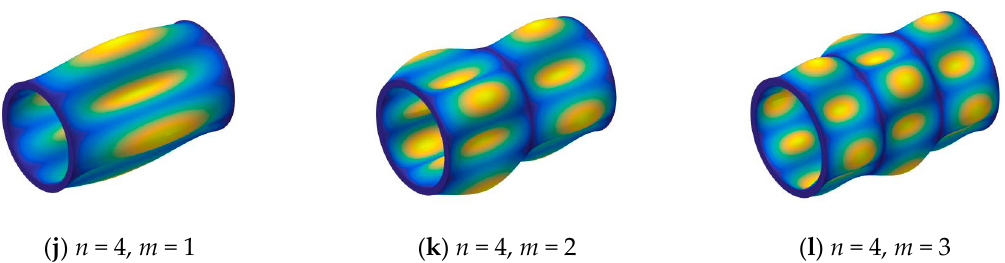
Figure 2. The modal shapes of a three-layered [0 ◦ / 90 ◦ / 0 ◦ ] composite shell with simply-supported (S-S) boundary conditions.